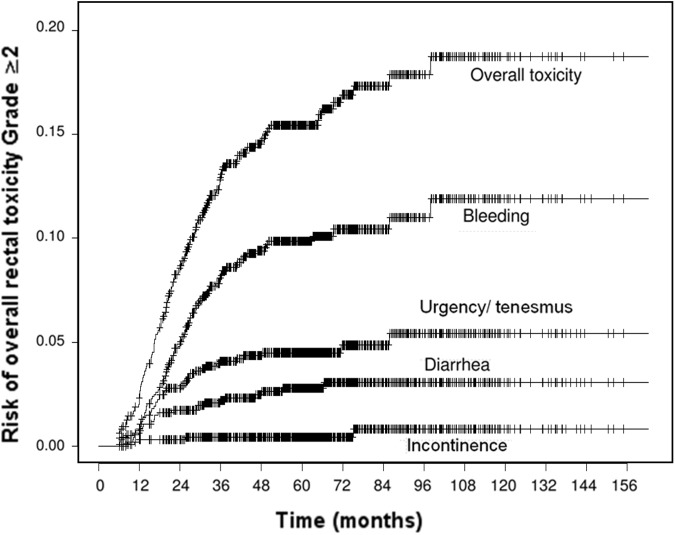
Risk of late rectal toxicity (Grade ≥2), overall and by symptoms (SOMA-LENT classification).